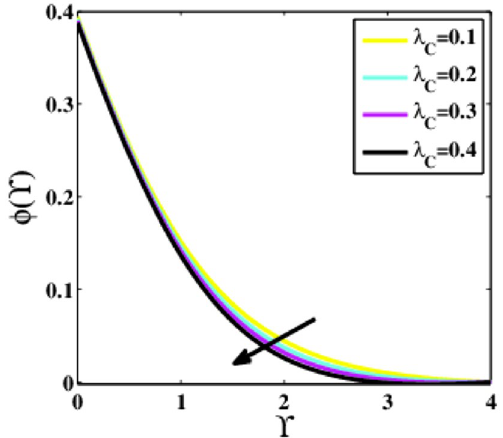
Figure 24. Plots of φ(ϒ) for (cid:31) C .